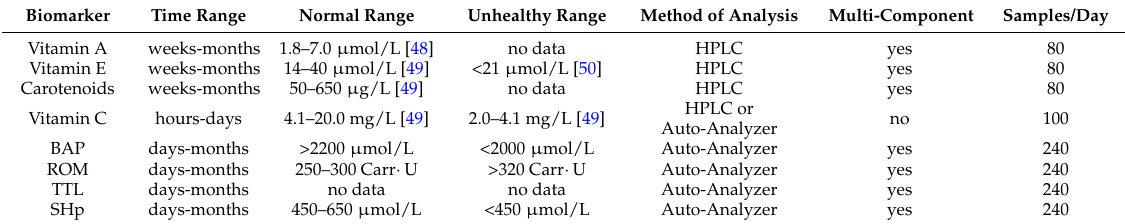
Table 1. Characteristics of the biomarkers selected for epidemiological